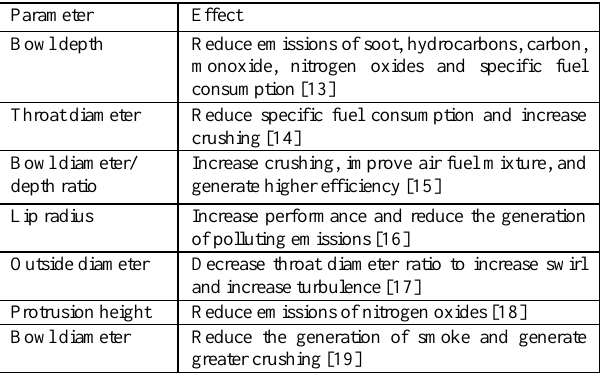
Table.1. Influence of changes in individual features of the combustion chamber of a piston of a diesel engine [10]